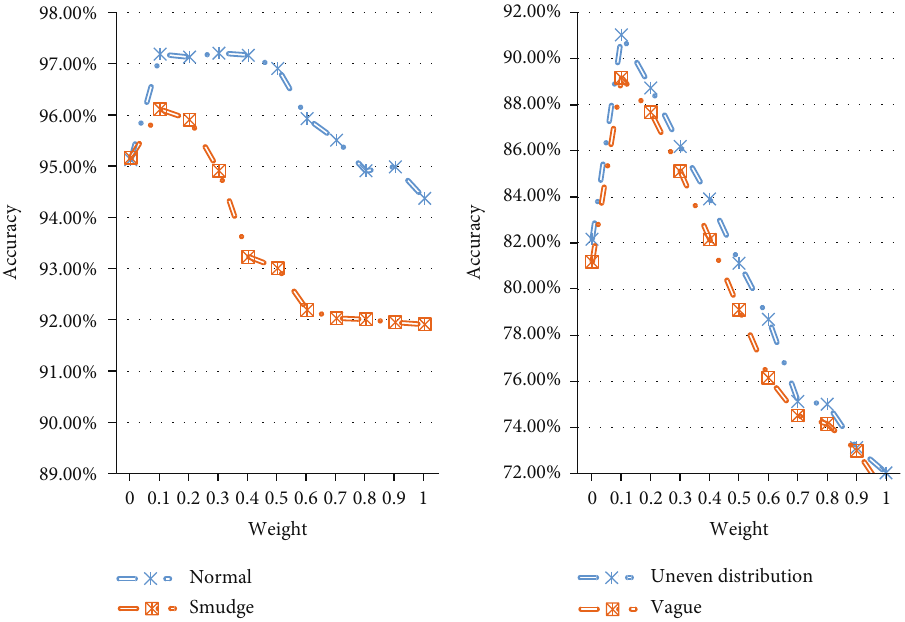
Figure 7: The relationship between the weights of di ff erent features and the segmentation accuracy.